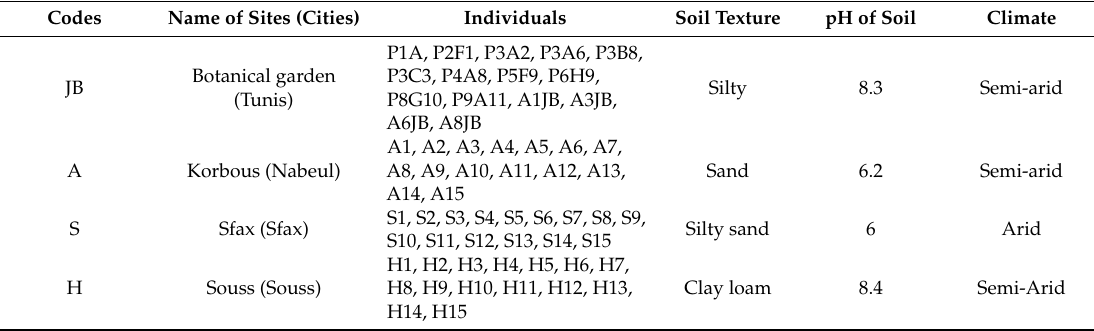
Table 7. Ecogeographic sites of selected argan trees in Tunisia and soil texture of each site.